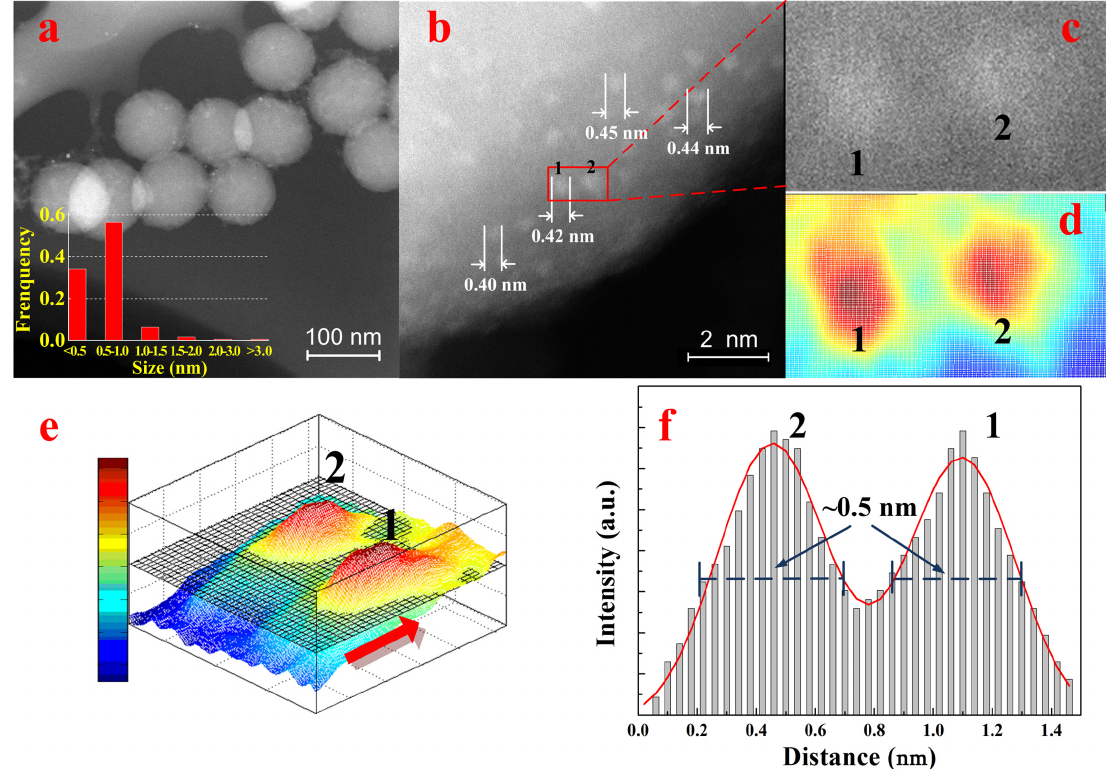
Figure 1. The typical Aberration ‐ corrected high ‐ angle annual dark ‐ filed scanning transmission electron microscopy (AC ‐ HAADF ‐ STEM) image and size distribution: ( a ) a selected and enlarged region from ( a ); ( b ) an enlarged area from ( b ); ( c ) a colorized intensity map from ( c ); ( d ) 2D Gaussian function fits to the intensity maps ( e ) and normalized intensity distributions received from the image ( e ) along arrow direction ( f ) of the 0.2 Pd/ZrO 2 catalyst. The size distribution (inset in ( a )) was based on over 400 Pd clusters from the high ‐ magnification images. The two Pd clusters in ( b ) were designated 1 and 2, respectively.